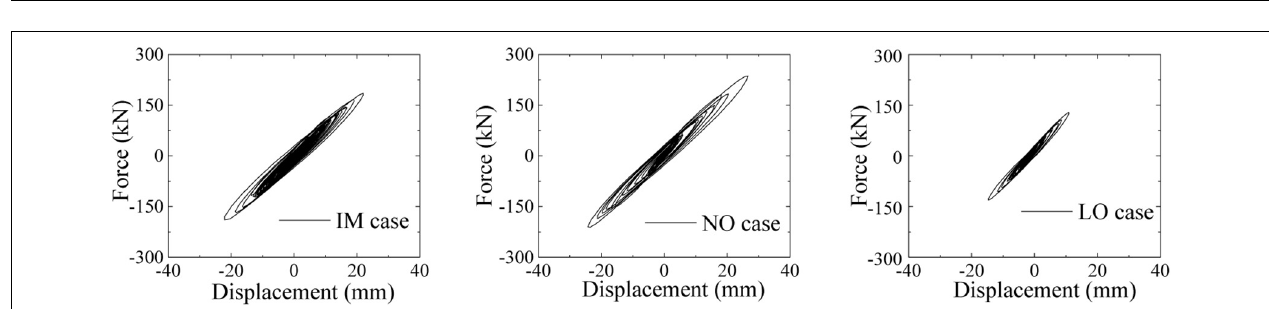
FIGURE 10 | Time histories of the shear force and deformation (LO case).